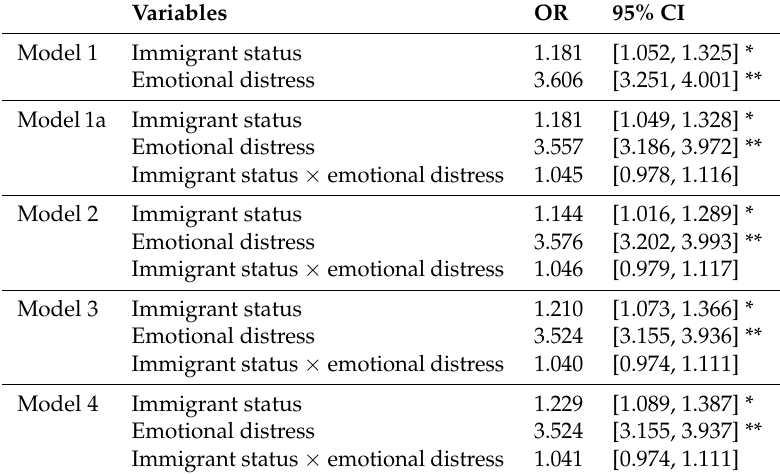
Model 1: unadjusted; Model 1a: unadjusted with interaction; Model 2: adjusted for age (weighted); Model 3: adjusted for patient characteristics (model 2 covariates plus weighted covariates: body mass index, marital status, income, children, smoking, alcohol consumption); Model 4: adjusted for comorbidity (model 3 covariates plus weighted covariates: arterial hypertension, heart disease, cancer, diabetes mellitus); OR: odds ratio; 95% CI: 95% confidence interval; * p < 0.05, ** p < 0.001. Table 5. Ordinal logistic regression models: associations between immigration status, emotional distress, and insomnia symptoms